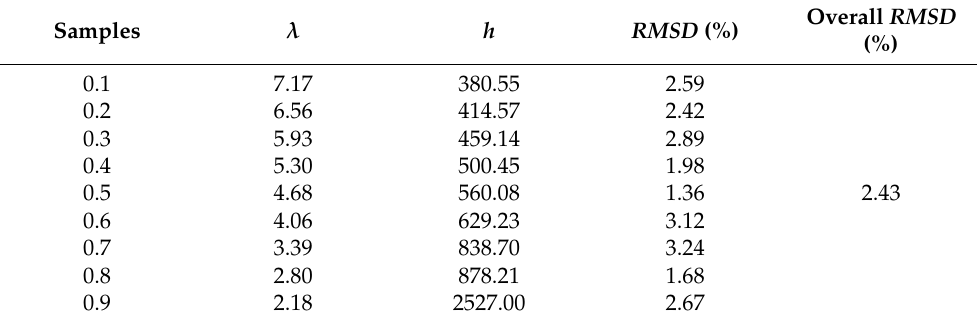
Table 8. The Buchowski–Ksiazczak λ h model parameters ( λ and h ) and RMSD values for TQ in various (IPA + H 2 O) compositions.